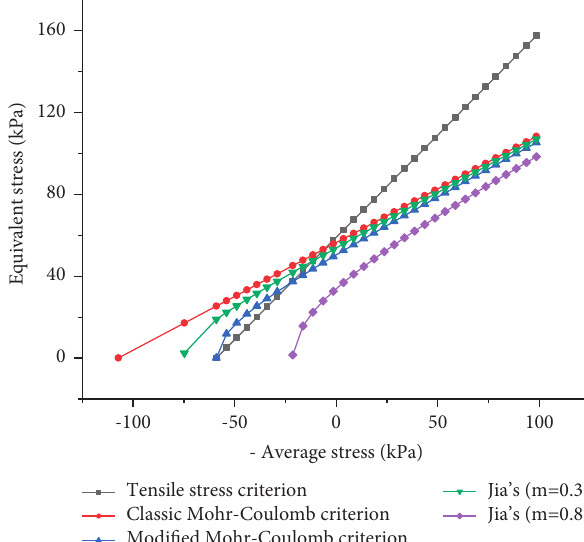
Figure 1: Yield criterion function used in this article.